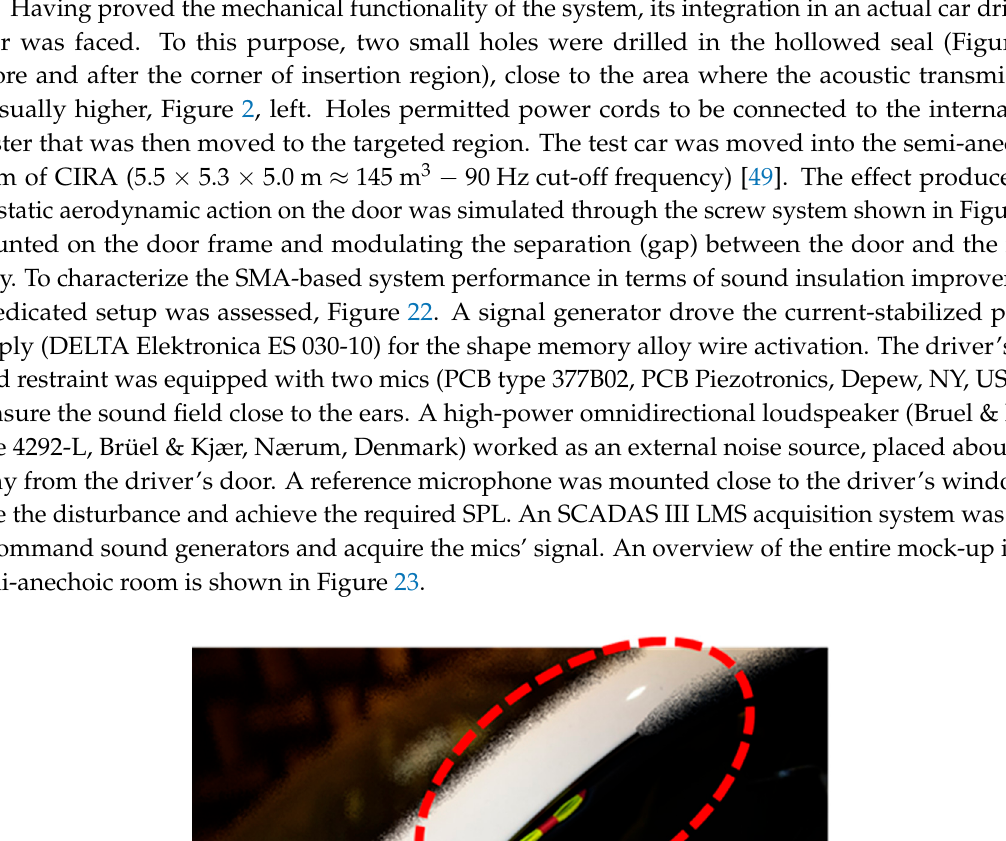
Figure 19. Cell functionality: Fully activated ( right ), no active ( left ).